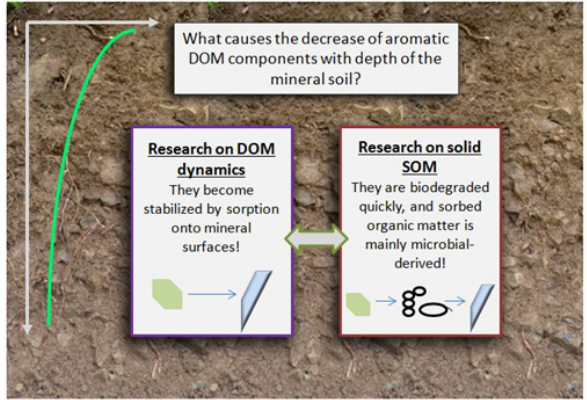
Figure 1. Conflicting views on the fate of soluble aromatics once they enter the mineral soil (see text for